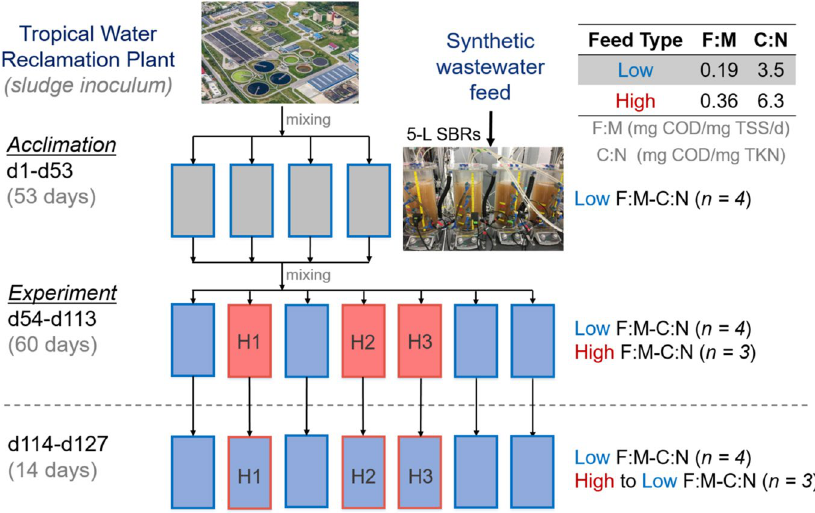
Figure 1. Schematic representation of the experimental design. F:M, food-to-biomass ratio; C:N, carbon-to- nitrogen ratio in the feed. Rectangles represent independent replicate 5-L SBRs. Phases: acclimation (grey), low F:M–C:N (blue, undisturbed), high F:M–C:N (red, press disturbed). Dashed line indicates removal of disturbance through the shift from high to low